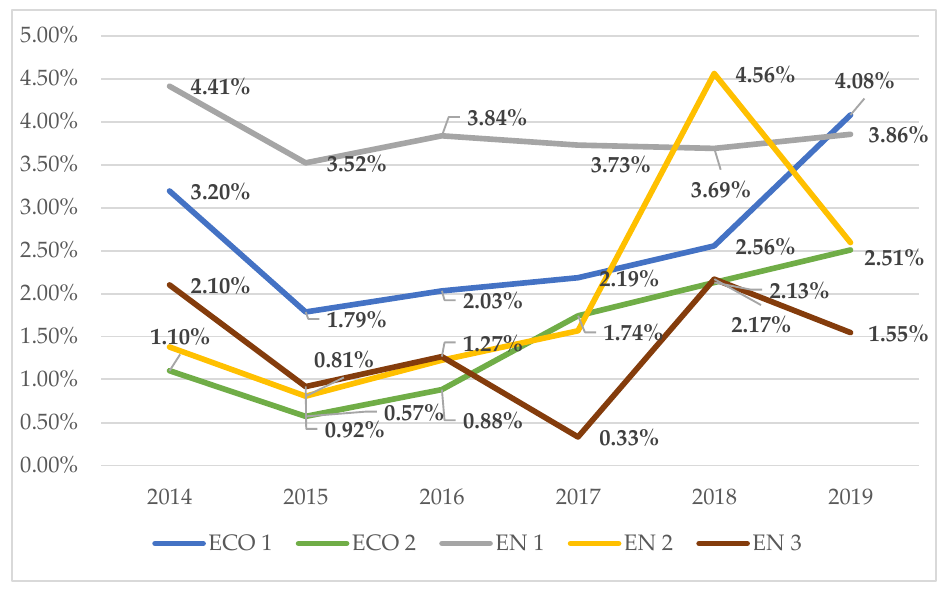
Figure 2. ROA at the surveyed research institutes in 2014 – 2019. Source: own compilation based on the financial statements.